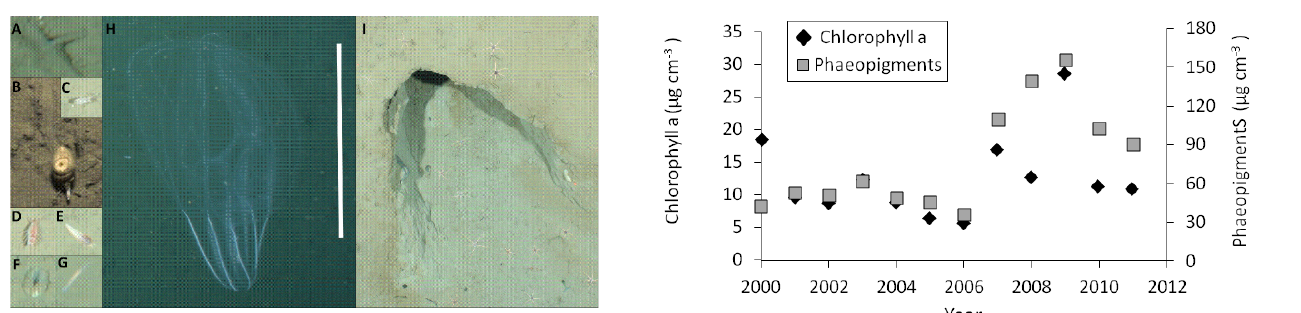
Fig. 7. Chlorophyll a and phaeopigment content cumulative over the top 5cm of sediment at HG I,